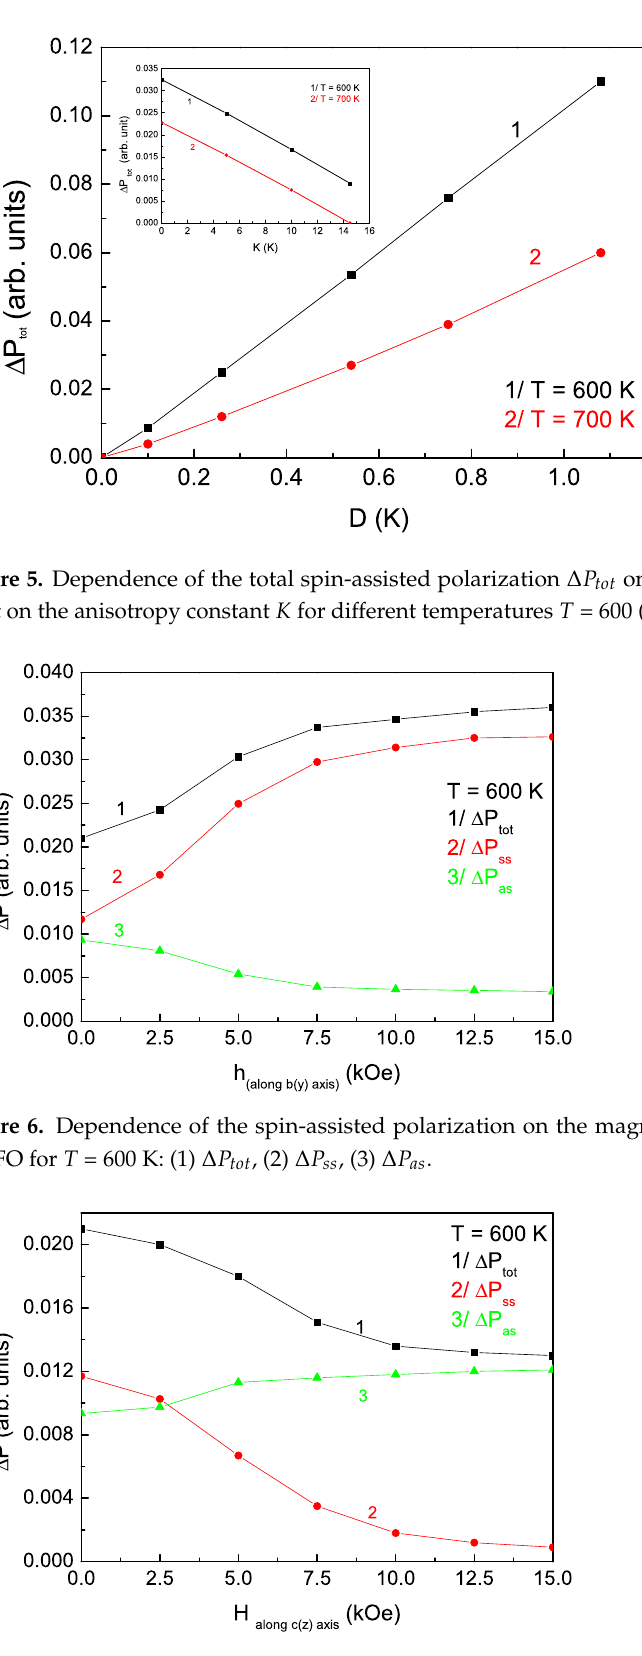
Figure 7. Dependence of the spin-assisted polarization on the magnetic field along the z axis of β -NFO for T = 600 K: (1) ∆ P tot , (2) ∆ P ss , (3) ∆ P as